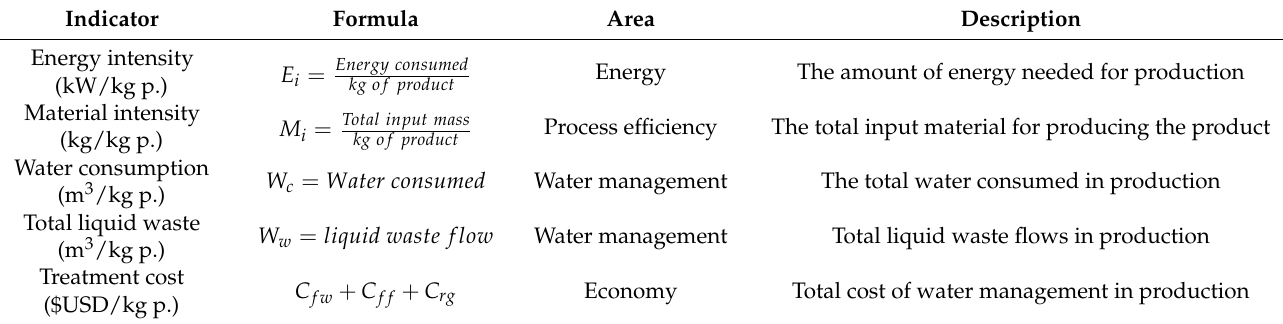
Table 1. Set of technical indicators for assisting sustainability